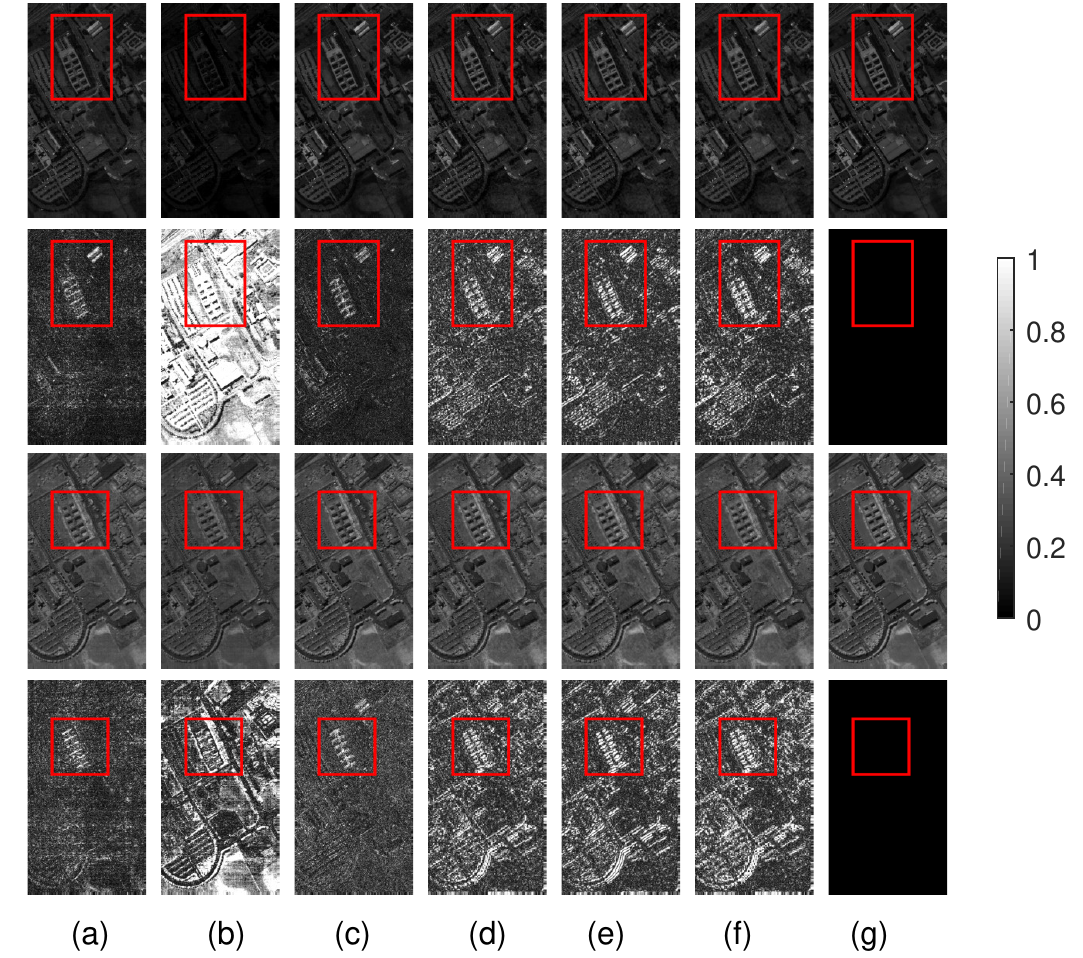
Figure 6. Reconstructed images and corresponding error images of Pavia University for the 20th and 60th bands with unknown D H and noisy D M : ( a ) JTF; ( b ) Blind STEREO; ( c ) CNMF; ( d ) SFIM; ( e ) MTF-GLP; ( f ) MAPSMM; ( g ) ground